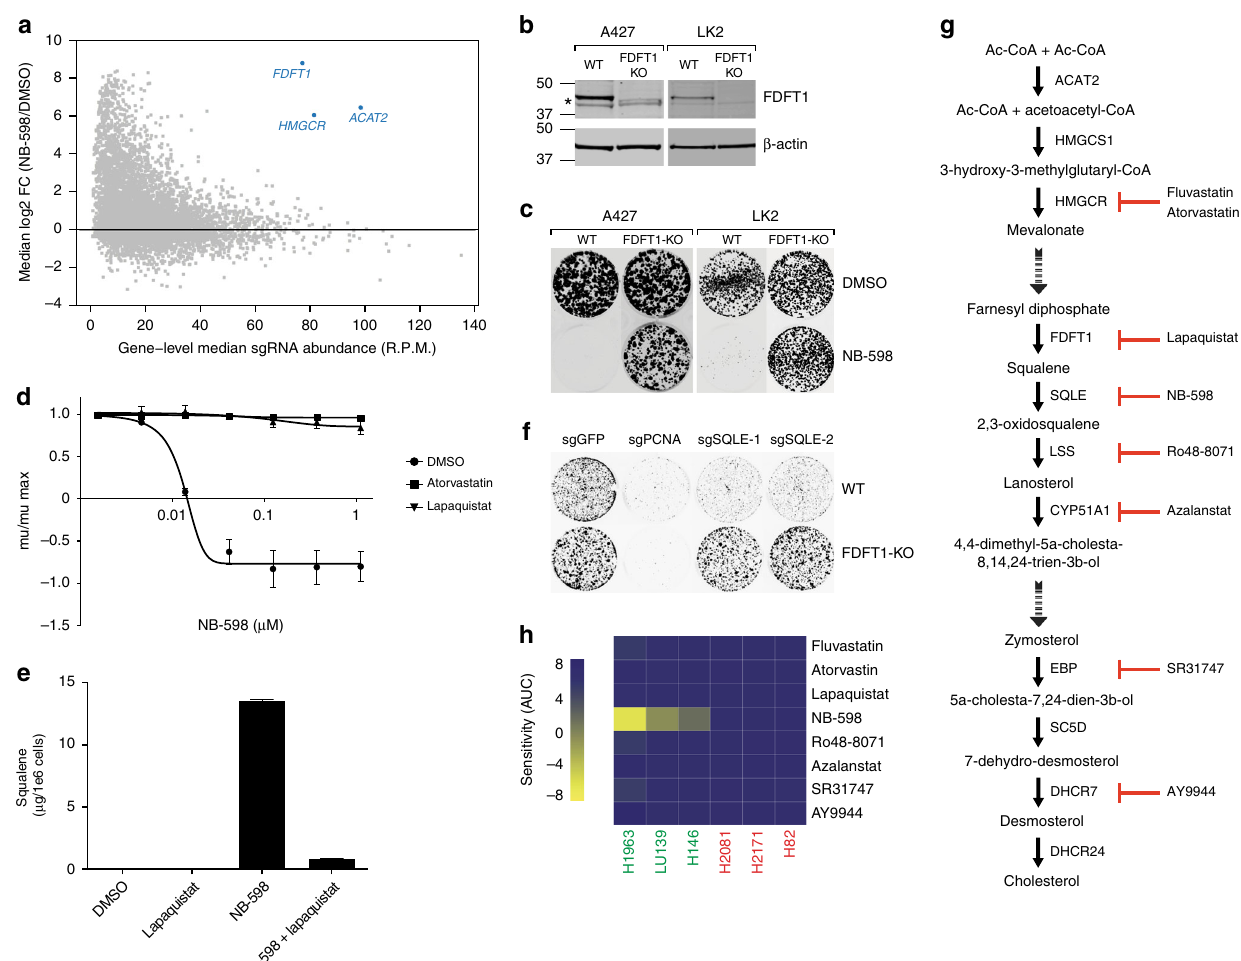
Fig. 5 Squalene accumulation is necessary for NB-598 ef fi cacy. a A CRISPR screen identi fi es multiple steps in the cholesterol biosynthetic pathway as suppressors of NB-598 ef fi cacy. The median log2-fold changes of targeting sgRNAs between NB-598 and DMSO control are plotted for all genes. The gene-level sgRNA abundance is plotted in reads per million (R.P.M.). b Immunoblot analysis showing no full-length FDFT1 expression in the FDFT1-KO cells in comparison to wild-type cells (A427 and LK2). Asterisk (*) indicates a non-speci fi c band. Molecular weight markers are indicated on the left in kDa units. c Suppression of NB-598 growth defects in FDFT1-KO clones in multiple independent cell lines (A427 and LK2). Cells were treated with 1 μ M NB- 598. Colony-formation assays were conducted in six-well plates. d Pharmacological suppression of NB-598 growth defects in LU139 cells using 10 μ M atorvastatin or 10 μ M lapaquistat. Mean values of triplicate measurements from a representative experiment are plotted and error bars represent s.d. e Treatment with 10 μ M lapaquistat suppresses squalene accumulation induced by 1 μ M NB-598 in LU139 cells. Mean values of triplicate measurements from a representative experiment are plotted and error bars represent s.d. f CRISPR-mediated KO of SQLE leads to growth defects in LK2 cells that are suppressed in the context of FDFT1-KO clone. sgRNA targeting an essential gene, PCNA , is used as a control. Colony-formation assays were conducted in six-well plates. g Schematic representation of the cholesterol biosynthetic pathway illustrating the site of action of multiple cholesterol pathway inhibitors. Simpli fi ed view of the pathway is shown, not accounting for multiple known bifurcating steps, such as di-oxidosqualene formation by SQLE or lanosterol to 24,25-dihydrolanosterol formation by DHCR24. h Relative sensitivities of a SCLC cell line panel to multiple inhibitors in the cholesterol pathway. AUC values derived from the mu/mu.max curves are shown. Top dose for each of the inhibitors was 3 μ